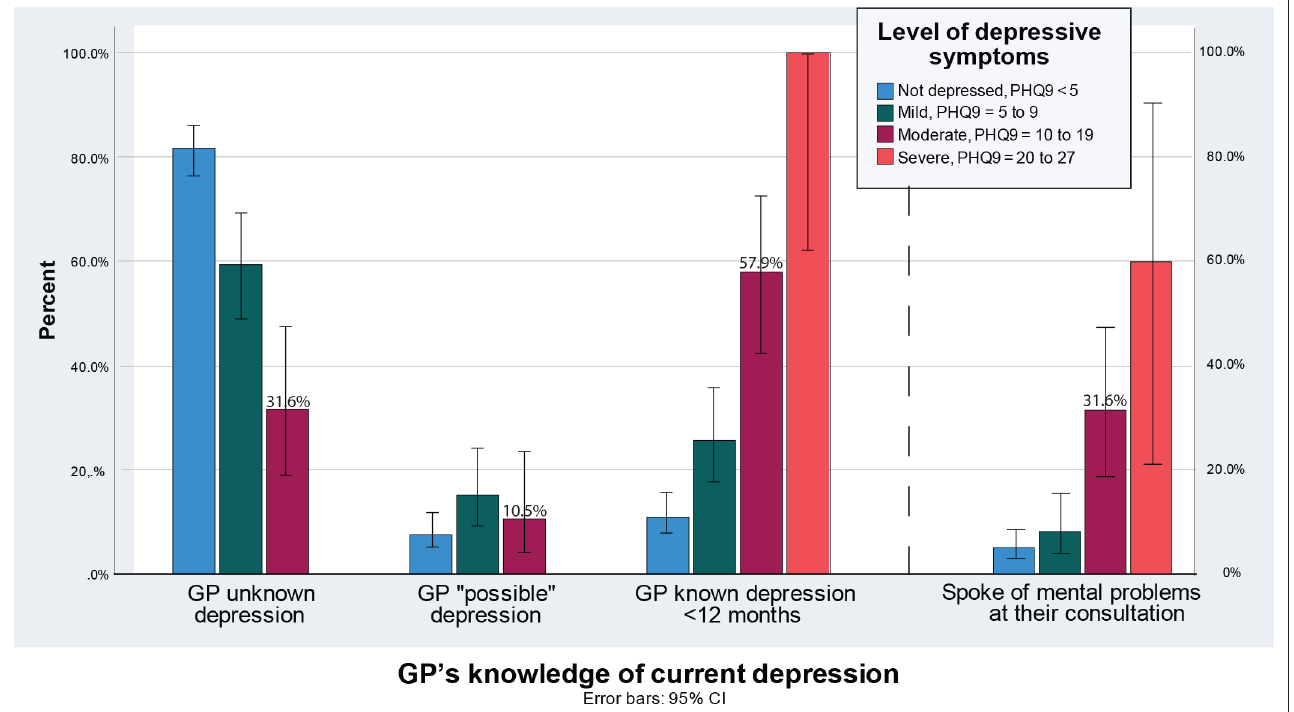
Figure 2 GP’s knowledge of a current depression, related to Patient Health Questionnaire- 9 score.